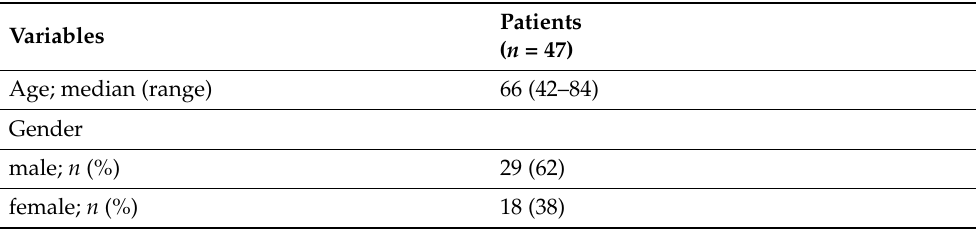
Table 1. Demographic and disease